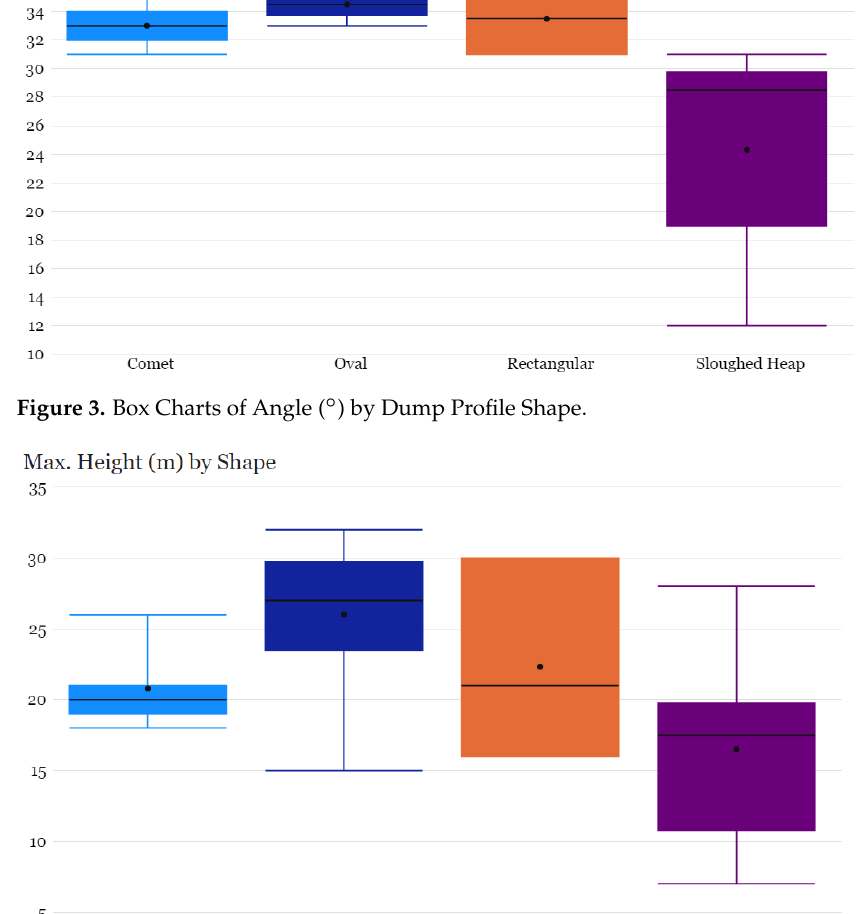
Figure 4. Box Charts of Max. Height (m) by Dump Profile Shape.